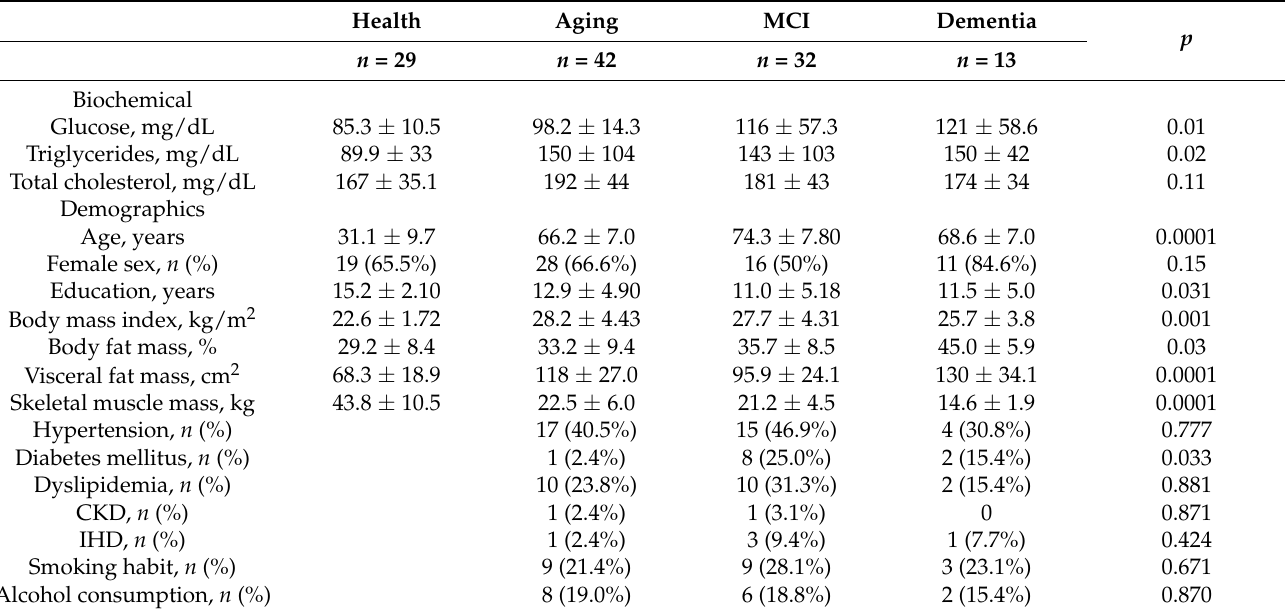
Table 1. Anthropometric and biochemical variables in healthy young subjects and older adults with mild cognitive impairment (MCI) and dementia